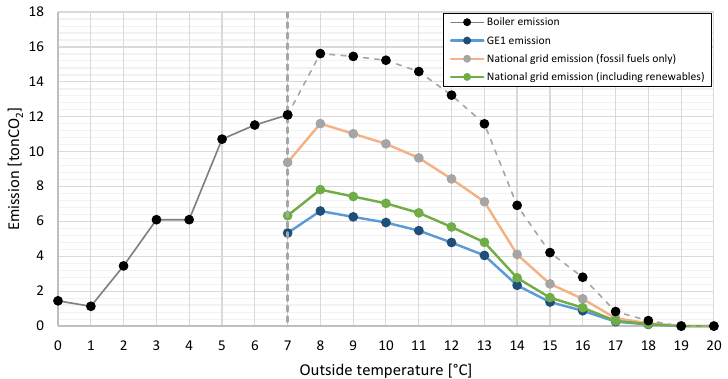
Figure 6. Evaluation of CO 2 footprint due to different solutions.